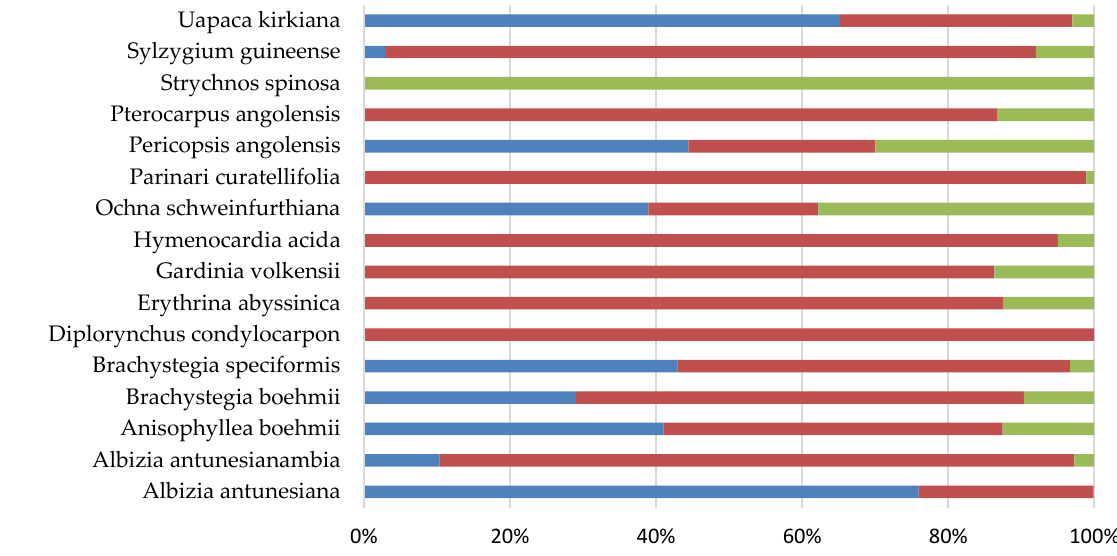
GlassLand/Savanna Figure 4. Abundance of the tree species in the classified land cover Figure 4. Abundance of the tree species in the classified land cover zones.